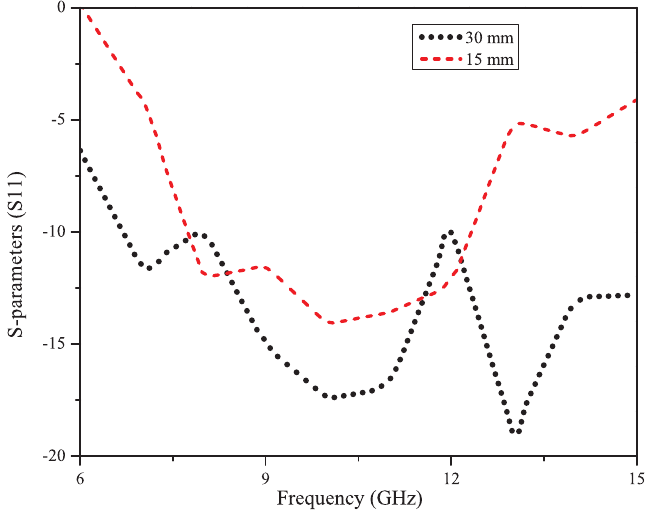
Figure 5. Effect of transition inside waveguide on